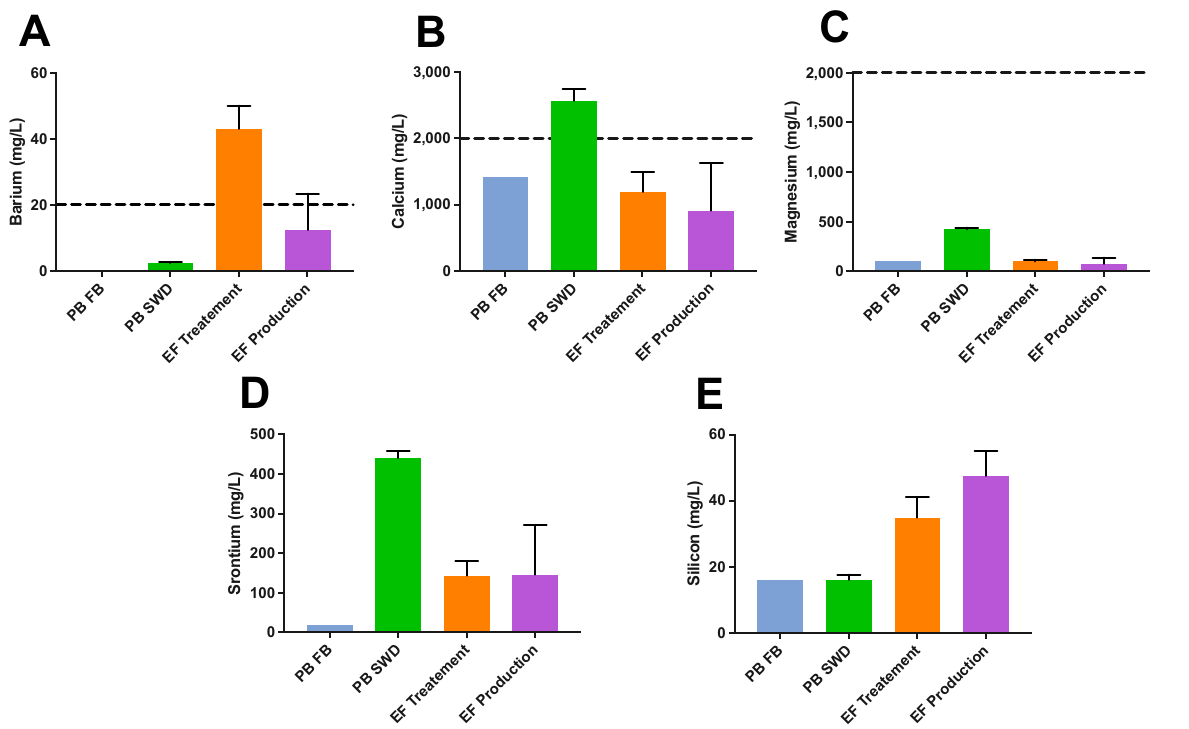
Figure 4. Scaling contributors for each PW sample set, including Permian Basin flowback, Permian Basin SWD, EF treatment facility, and EF production wells, all represented in the graphs. Data are presented as mean values for ( A ) barium, ( B ) calcium, ( C ) magnesium, ( D ) strontium, and ( E ) silicon with the error bars representing standard error of the mean. Dotted lines mark the recommended maximum reuse limit suggested by Hildenbrand, King, Oetjen, and Liden et al. [5,27–29].